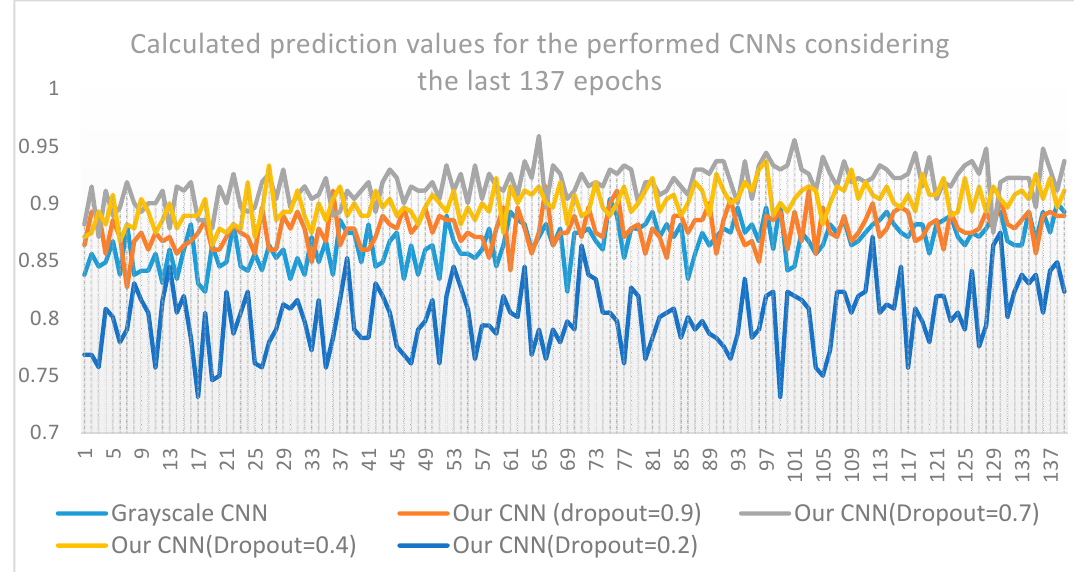
Figure 7. Average prediction errors for the best CNN architecture.